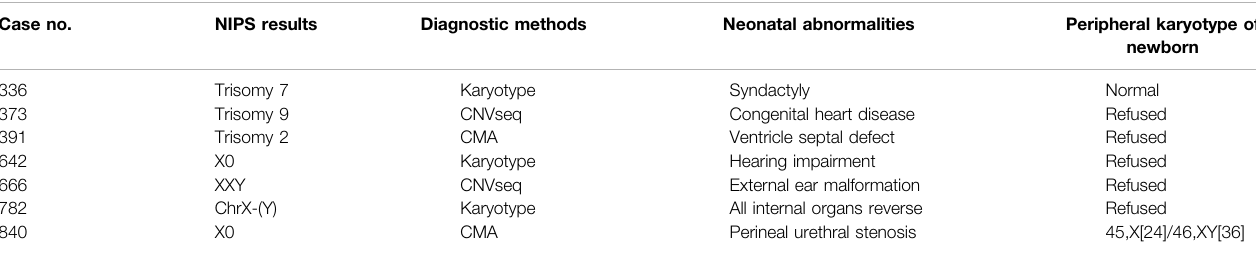
TABLE 7 | Details of abnormal newborns with negative prenatal diagnoses. Case